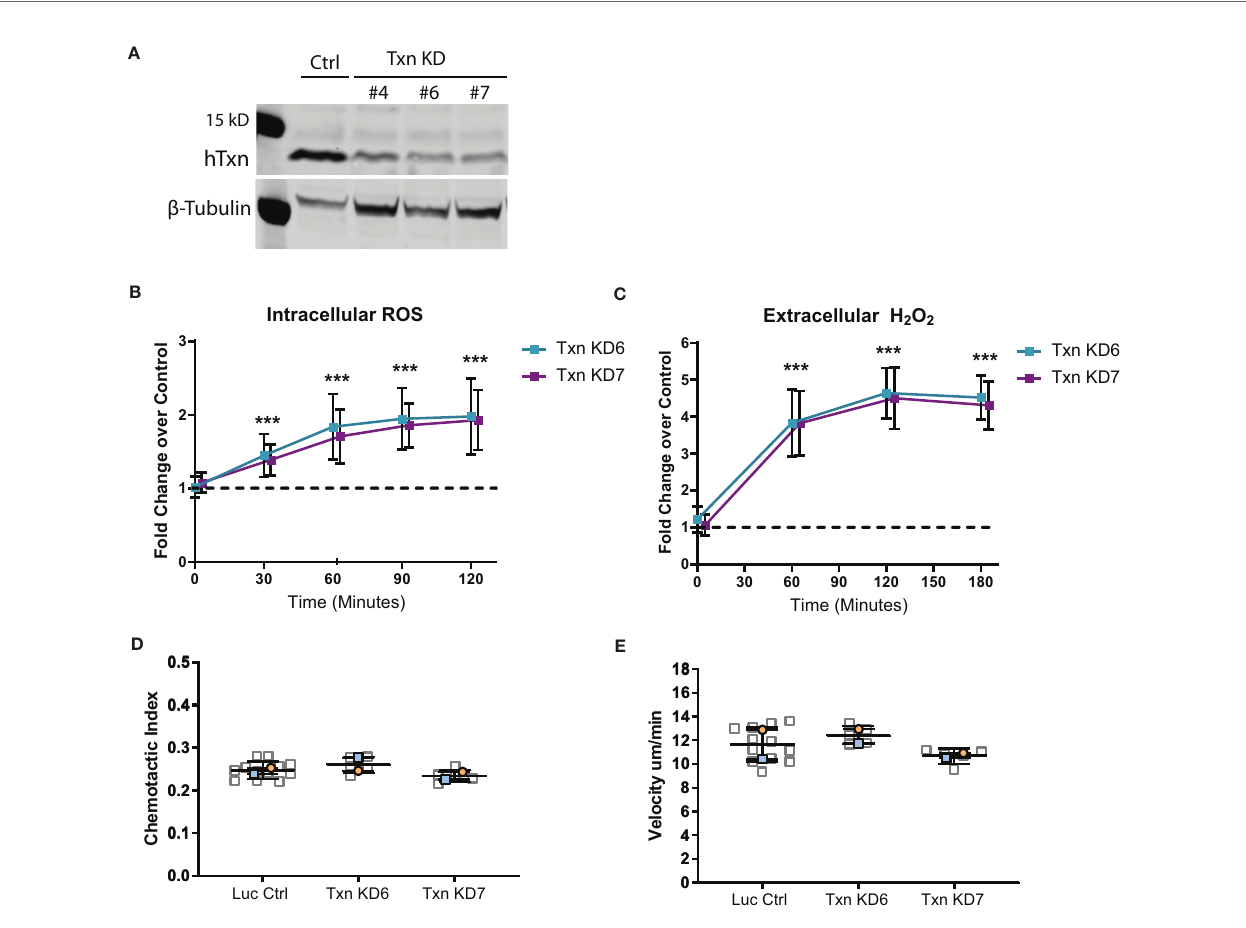
FIGURE 4 | Thioredoxin depletion in a neutrophil-like cell line increases ROS but does not intrinsically affect motility. (A) Western blot of thioredoxin con fi rming CRISPR/Cas9 mediated txn knockdown in three HL60 clonal lines (KD4, KD6 and KD7) compared to luciferase control, with beta-tubulin as a loading control. (B) Quanti fi cation of intracellular ROS production (Carboxy-H2DCFDA probe) over time in txn knockdown lines compared to control (n=3). (C) Quanti fi cation of extracellular H 2 O 2 production (Amplex Red/HRP Probe) over time in txn knockdown lines compared to control (n=3). (D) 2D chemotactic index and (E) mean track speed for txn knockdown lines compared to control (N = 2 repeats, n = 5-12 devices). Samples were analyzed for statistical signi fi cance via generalized estimating equation (GEE) fi t to the log fold change with con fi dence intervals set to 95% coverage (B, C) or t-test (D, E) (p <